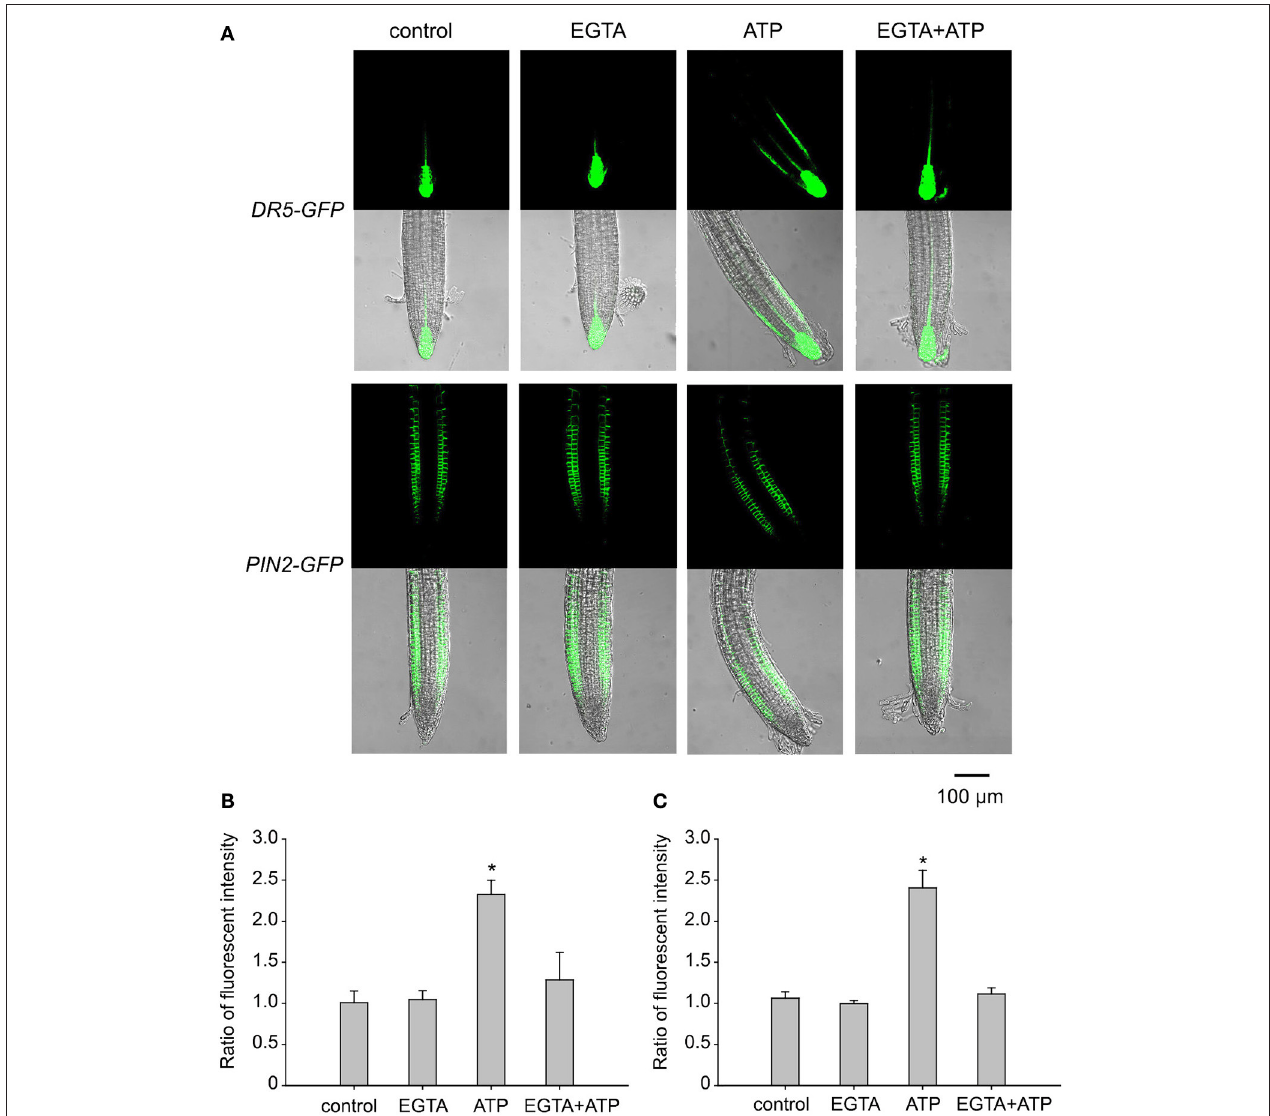
FIGURE 7 | Ca 2 + is involved in eATP-induced asymmetric distribution of DR5-GFP and PIN2-GFP. DR5-GFP or PIN2-GFP transgenic WS seedlings grown in 1/2 MS medium for 4 days were transplanted onto jointed medium containing 0.5 mM EGTA (in both the upper and the lower part) and 0.5 mM ATP (in the lower part only). After 24 h, fluorescence was detected by using CLSM. (A) Fluorescence in representative root tip cells. The scale bar is showed below. (B,C) note the fluorescence intensity ratio (fluorescence intensity in right-side cells relative to that in left-side cells) of DR5-GFP (B) and PIN2-GFP (C) , respectively. In each experiment, fluorescence intensity in up to 10 roots was measured. Data from 3 replicates were calculated to get the mean ± SD. Student’s t -test p -values: * p <